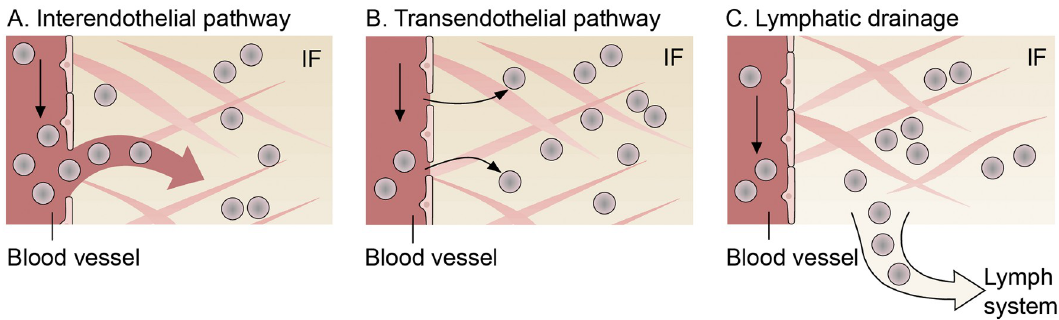
Fig 2. Mechanisms for nanoparticle transport to and from the interstitial fluid (IF). Transcapillary exchange of nanoparticles from the vasculature to the IF consisting of (A) the interendothelial and (B) the transendothelial pathway; (C) Lymphatic drainage for transport from the IF to the lymph